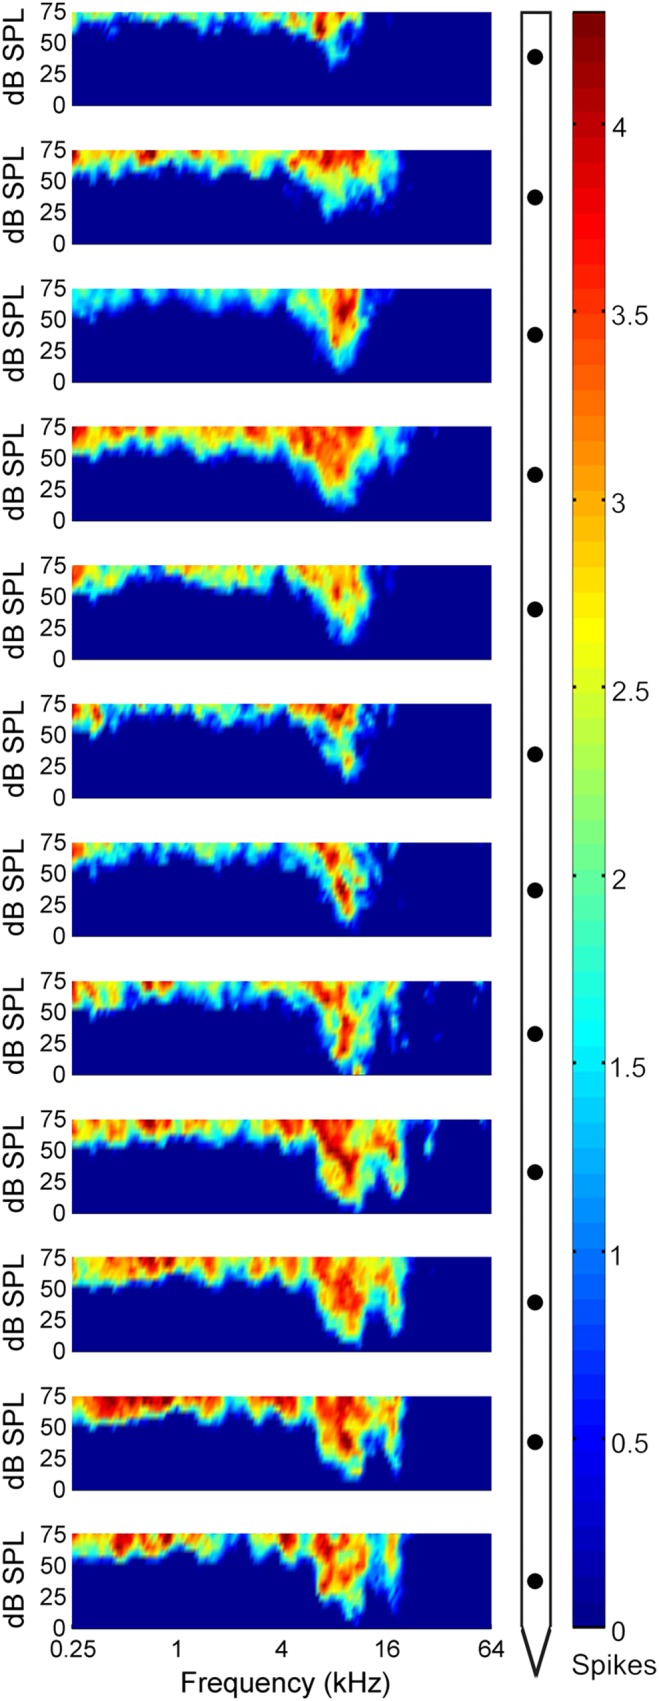
Neuronal tuning within a primary auditory cortex column.Acoustic receptive fields of neurons within the cortical track highlighted in Fig. 7. Measures of characteristic frequency (CF), defined as the tone frequency that evoked a reliable response at the lowest acoustic intensity level, were conducted by an experienced observer blind to stimulus conditions. Note that CFs remain constant irrespective of cortical depth and as such provide evidence that the electrode trajectory was orthogonal to the cortical tissue.